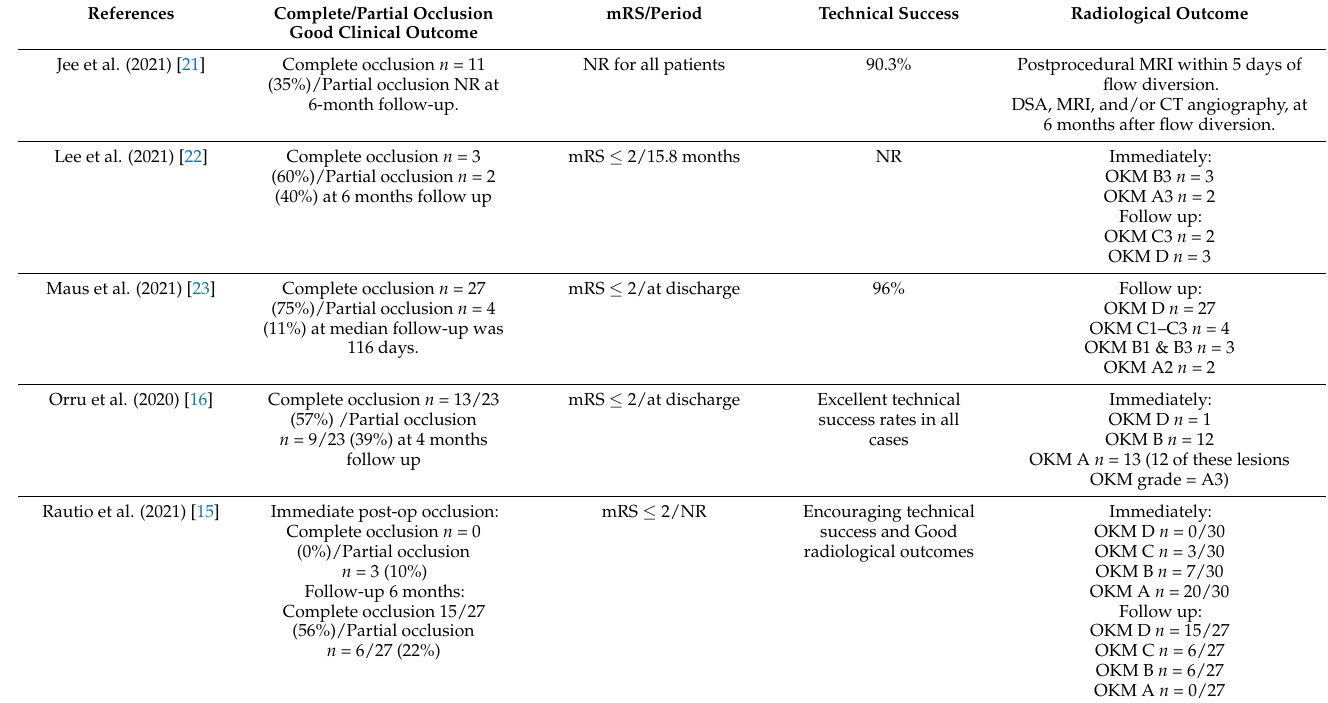
Table 5. SE-FDs outcomes.